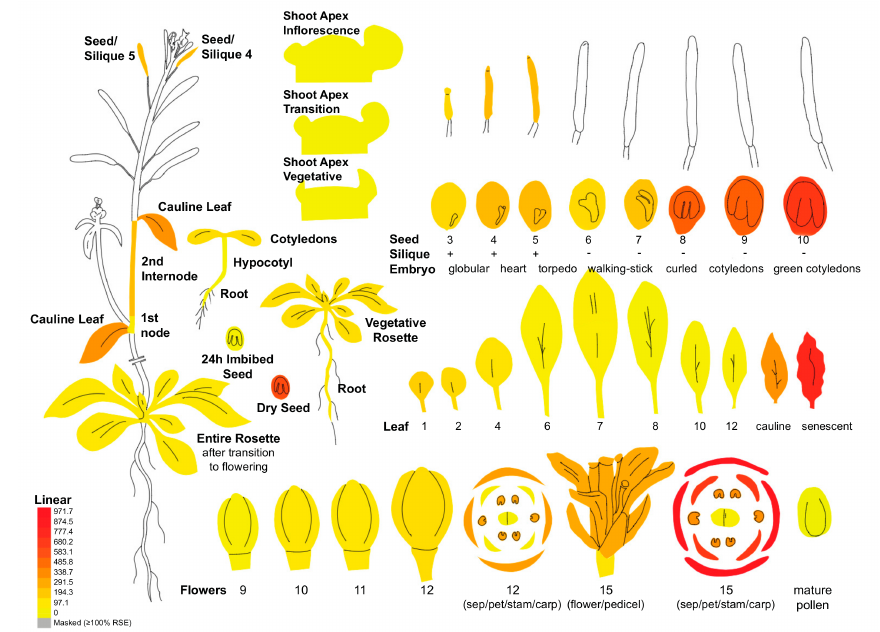
Figure 3. HPPD expression pattern during Arabidopsis development. The expression of the Arabidopsis HPPD gene (At1g06570) was assessed with ePlant (http://bar.utoronto.ca/eplant). HPPD expression level is equal to 697.5 in green cotyledons (SD = 36.3; n = 3), and is the third highest HPPD expression after sepals (level = 971.7; SD = 84.2; n = 3) and senescent leaves (level = 797.7; SD = 6.9; n =